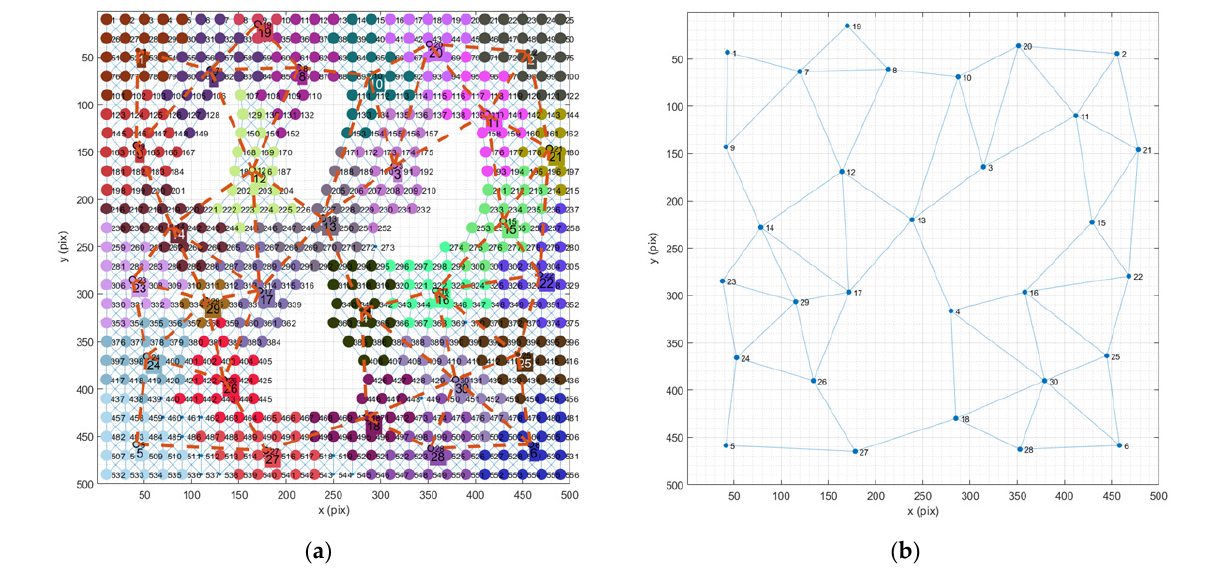
Figure 6. ( a ) The clusters 𝑔 (cid:3038) connected by vertices 𝑉 (cid:2868) . ( b ) The corresponding graph of clusters 𝐺 (cid:2868) .